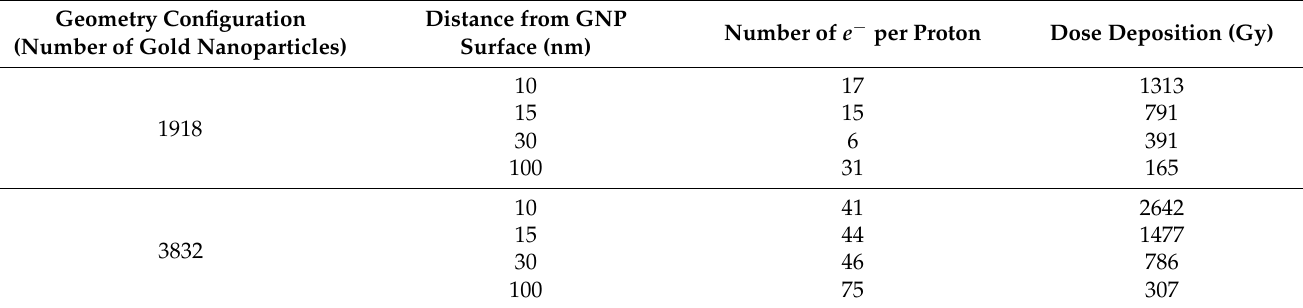
Table 1. Number of secondary electrons at different GNP